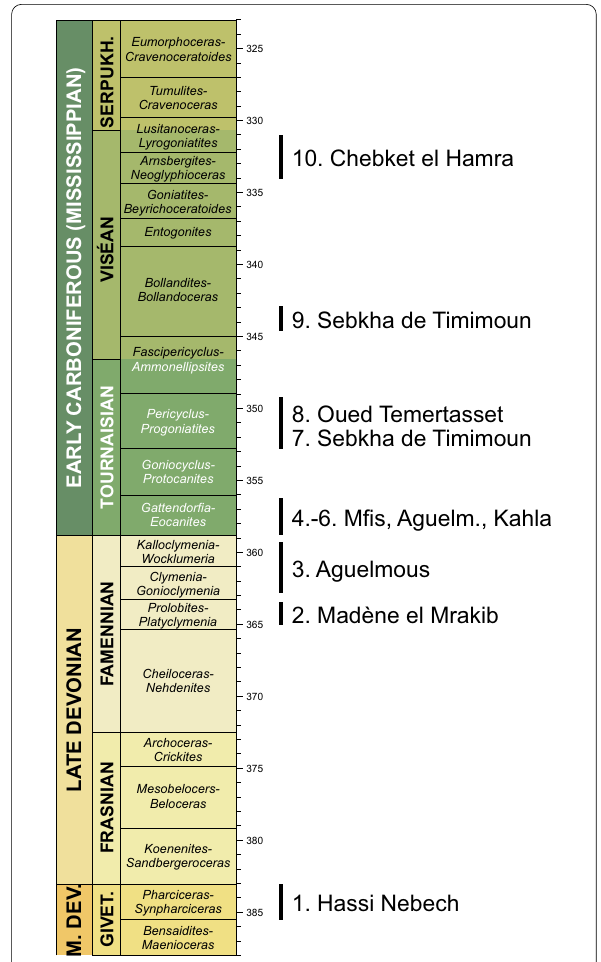
Fig. 2 The stratigraphic position of the studied